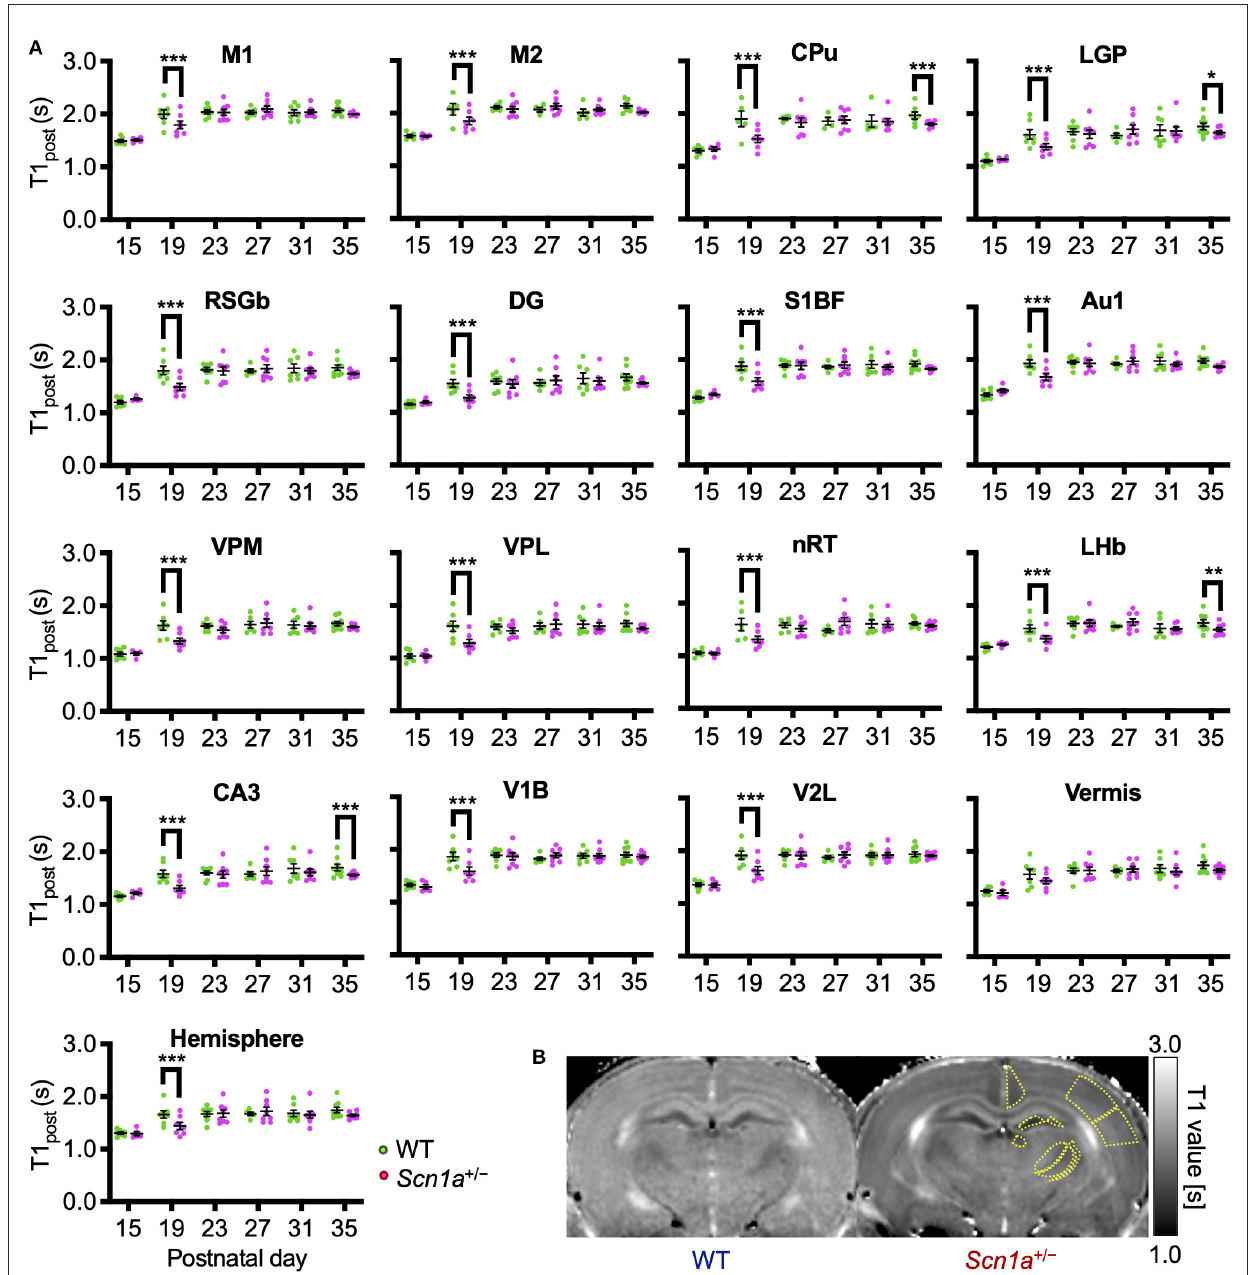
FIGURE3 Age-dependent changes in T1 post in each brain region of wild-type and Scn1a + / − rats. (A) T1 post showed age-dependent changes in each region of wild-type (WT, green circle) and Scn1a + / − rats ( Scn1a + / − , magenta circle). Tukey multiple-comparison test showed a significant decrease in T1 post of Scn1a + / − rats during P19–22: M1(mean difference 0.205s; 95% CI 0.073–0.337s), M2 (0.198s; 0.066–0.330s), CPu (0.355s; − 0.203–0.467s), LGP (0.247s; 0.115–0.380s), RSGb (0.318s; 0.203–0.467s), DG (-0.272s; 0.140–0.404s), S1BF (0.299s; 0.167–0.431s), Au1 (0.269s; 0.137–0.401s), VPM (0.286s; 0.154–0.419s), VPL (0.316s; 0.184–0.448s), nRT (0.280s; 0.142–0.418s), LHb (0.202s; 0.070–0.334s), CA3 (0.277s; 0.145–0.409s), V1B (0.278s; 0.147–0.410s), V2L (0.291s; 0.159–0.423s), Vermis (0.126s; − 0.006–0.258s), and Hemisphere (0.229s; 0.097–0.361s). These differences disappeared after P23, but are significantly decreased during P35–38: CPu (0.148s; 0.028–0.268s), LGP (0.120s; 0.000–0.240s), LHb (0.136s; 0.012–0.260s), and CA3 (0.143s; 0.023–0.263s). Tukey’s multiple-comparison test; * p < 0.05, ** p < 0.01, *** p < 0.001. Data are presented as mean ± standard error of the mean (SEM). Dots represent individual data points. (B) Representative MEMRI T1 map at P21. Yellow lines show part of regions of interest. MEMRI, manganese-enhanced magnetic resonance imaging; M1, primary motor cortex; CI, confidence interval; M2, secondary motor cortex; CPu, caudate-putamen (striatum); LGP, lateral globus pallidus; RSGb, retrosplenial granular b cortex; DG, dentate gyrus; S1BF, primary somatosensory cortex, barrel field; Au1, primary auditory cortex; VPM, ventral posteromedial thalamic nucleus; VPL, ventral posterolateral thalamic nucleus; nRT, reticular thalamic nucleus; LHb, lateral habenular nucleus; CA3, CA3 field of the hippocampus; V1B, primary visual cortex, binocular area; V2L, secondary visual cortex, lateral area; Vermis, cerebellar vermis; Hemisphere, cerebellar hemisphere; P, postnatal